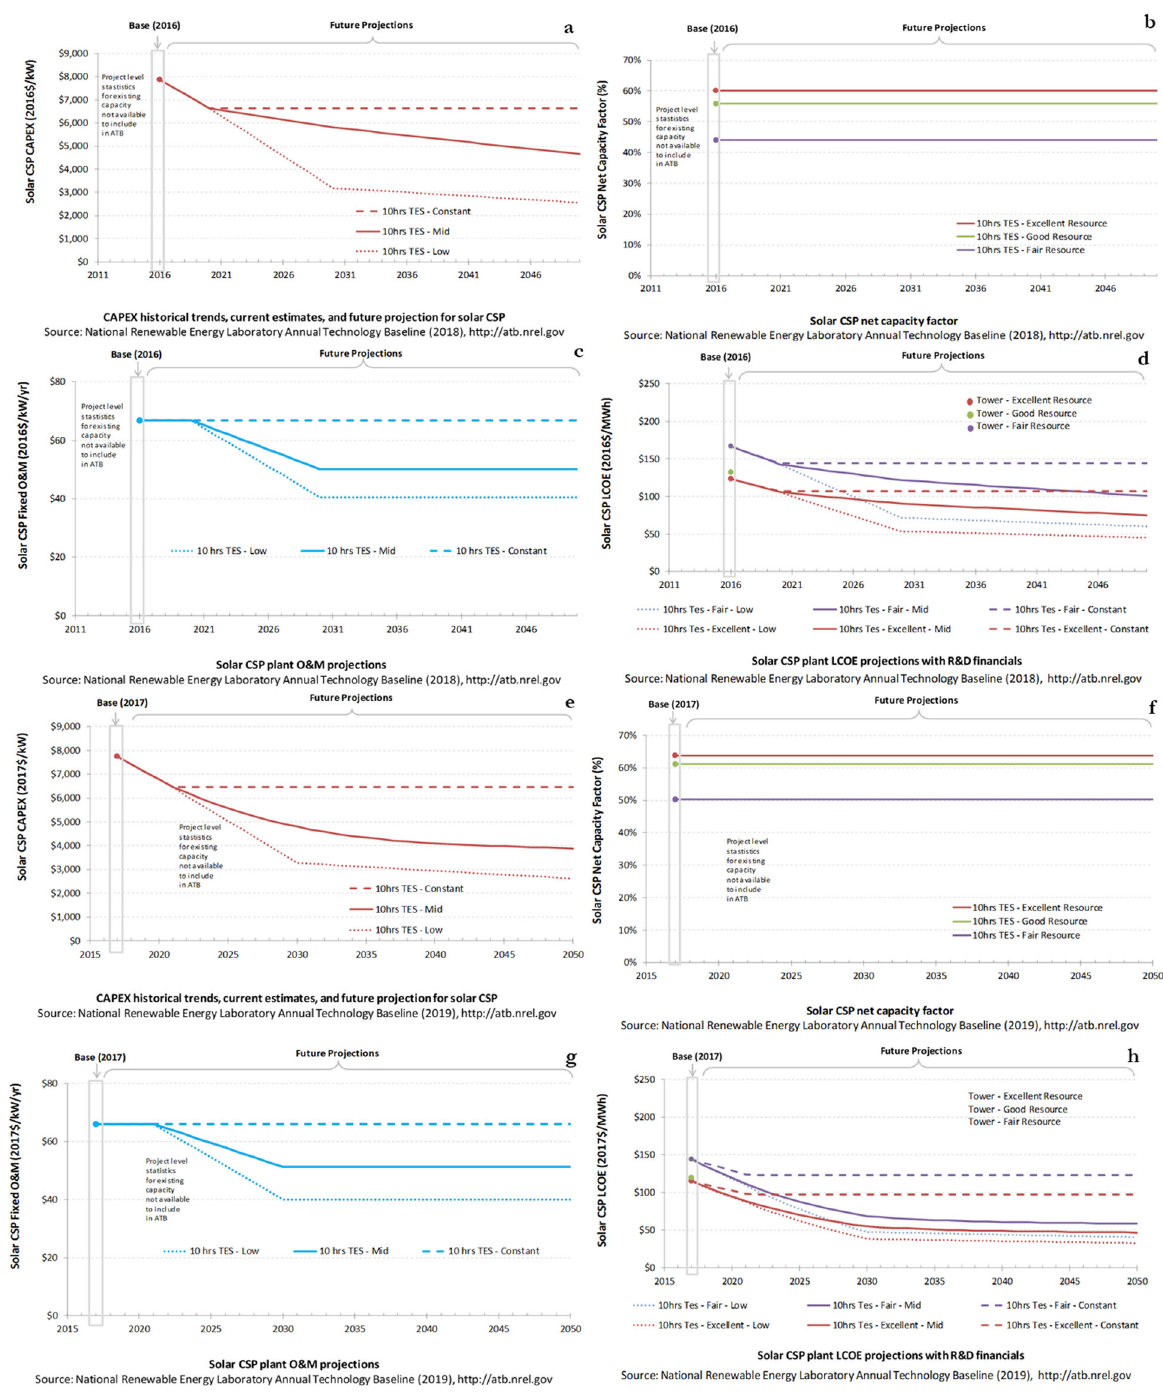
Fig. 4 Techno-economic performances of future CSP ST plants with TES. a – d The version 2018 of the NREL Annual Technology Baseline data for CSP, e – h the version 2019. a The CAPEX (CAPital EXpenditures) in 2016 US$ per kW of power installed. b The net capacity factor ε . c The O&M costs. d The Levelized costs of electricity. Images reproduced after NREL (2018). e – h The same projections of techno-economic parameters in version 2019. Images reproduced after NREL (2019). Credit